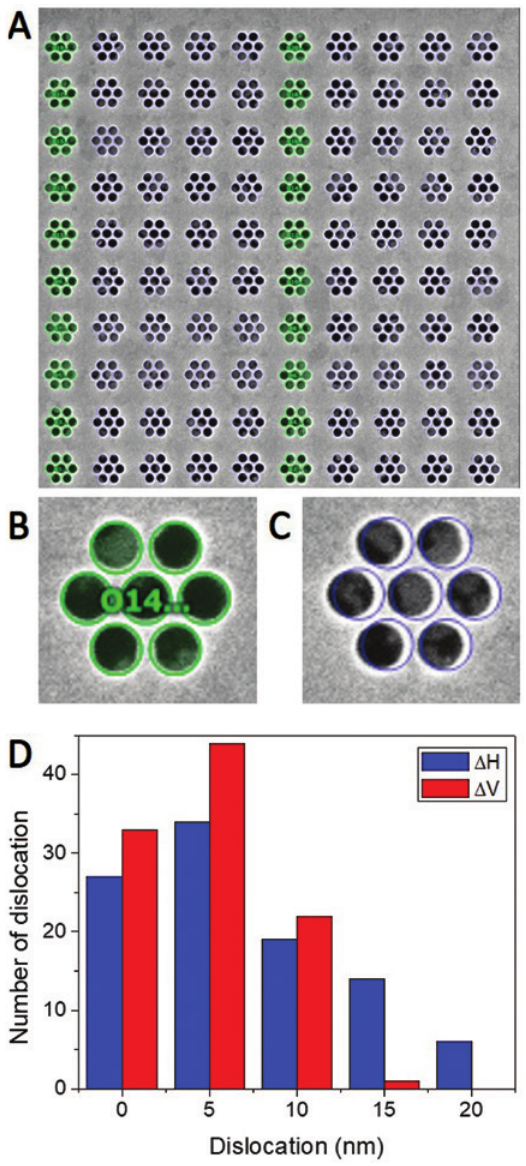
Figure 3: Dislocation of HNHs with drift correction. (A) HIM image of fabricated HNH array overlapped with the patterning layout. Digital zoomed-in image of a single HNH for (B) Δ H = Δ V = 0 and (C) Δ H = 20 nm and Δ V = 5 nm. (D) Distribution of dislocations in the horizontal ( Δ H ) and vertical ( Δ V ) directions for each HNH in an